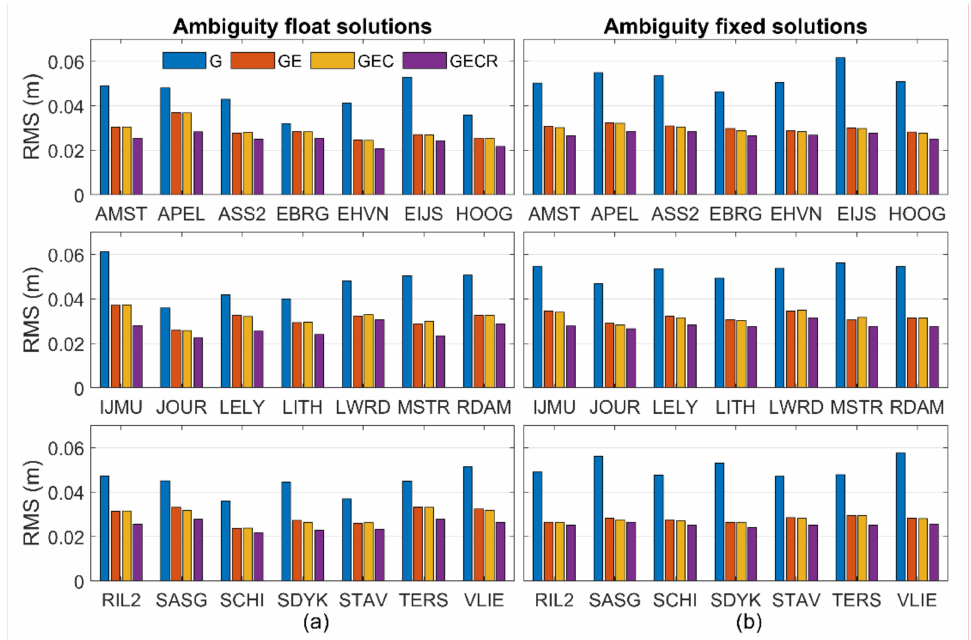
Figure 3. Three-dimensional (3D) positioning accuracy of the ( a ) ambiguity float solution and ( b ) ambiguity fixed